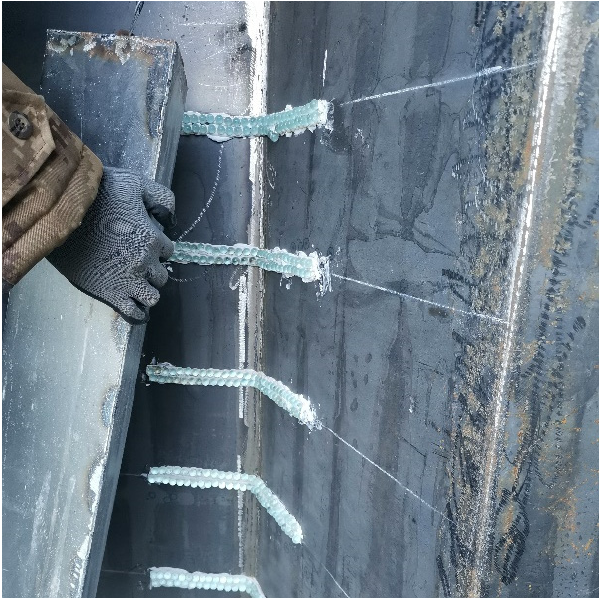
Figure 6. The glass ball sliding track arranged on the contact surface with the fixed target. The diameter of the projectile is 76 mm, and the length-to-diameter ratio is 6. The ratio of the radius of curvature of the head to its diameter is 3, and the weight of the projectile is about 14.1 kg, while the weight of the diamond-shaped moving target is about 28.2 kg, thus the mass ratio of them is 1:2. The projectile material is ultra-high-strength alloy steel 30CrMnSiNi2A, the yield strength is 1766 MPa, and the Rockwell hardness of the material after heat treatment is not less than 45. Using sub-aperture launch technology, the photo of the 76 mm test projectile body and the split-lobe stock is shown in Figure